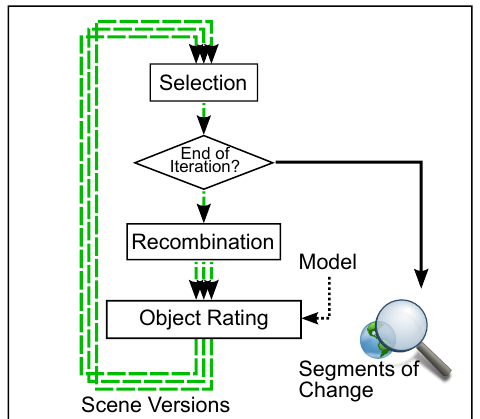
Figure 3: Flow chart showing the system’s evolutionary part after